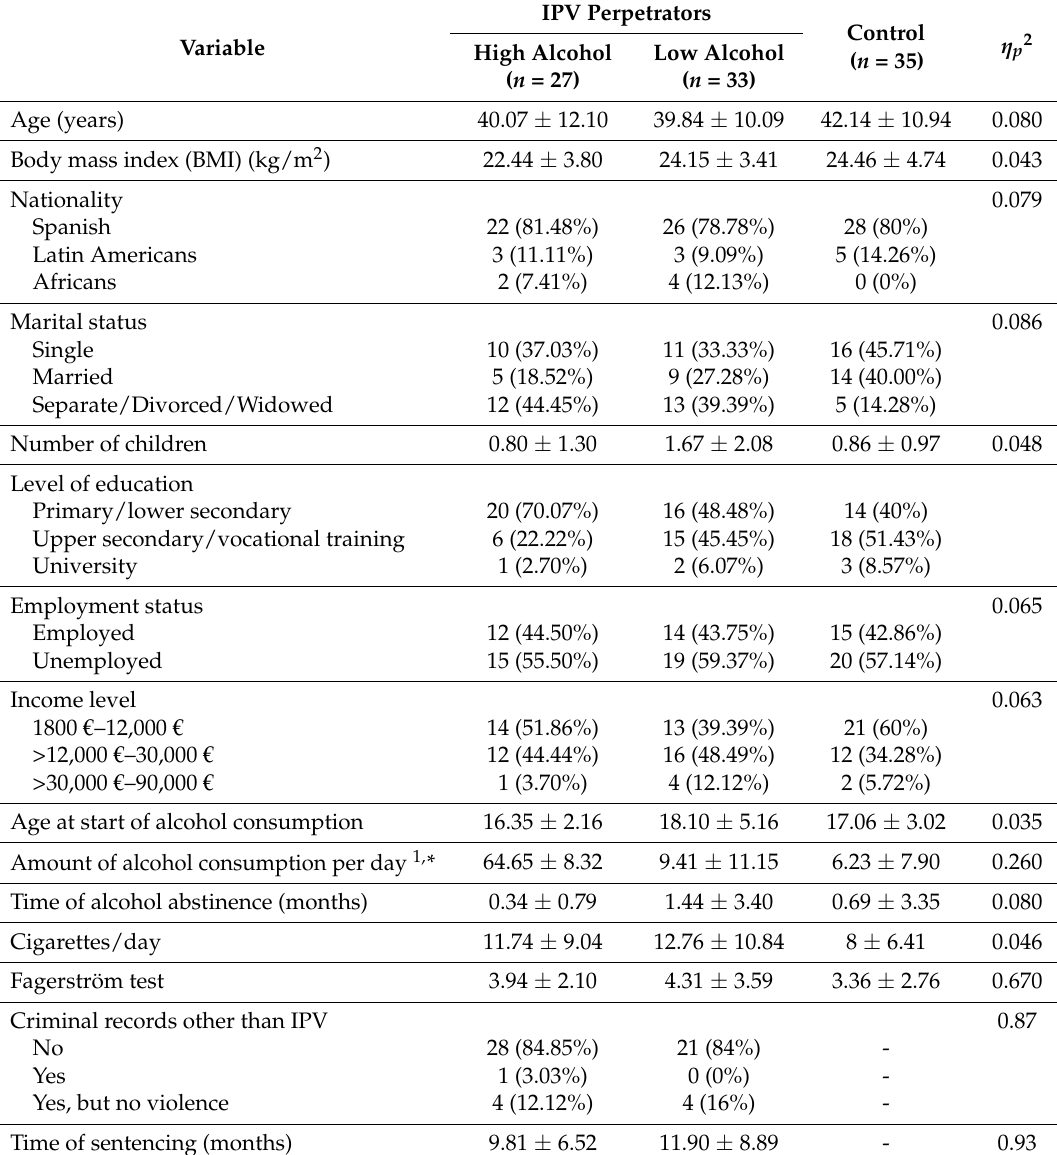
Table 1. Mean ± SD of descriptive characteristics for all groups (* p <